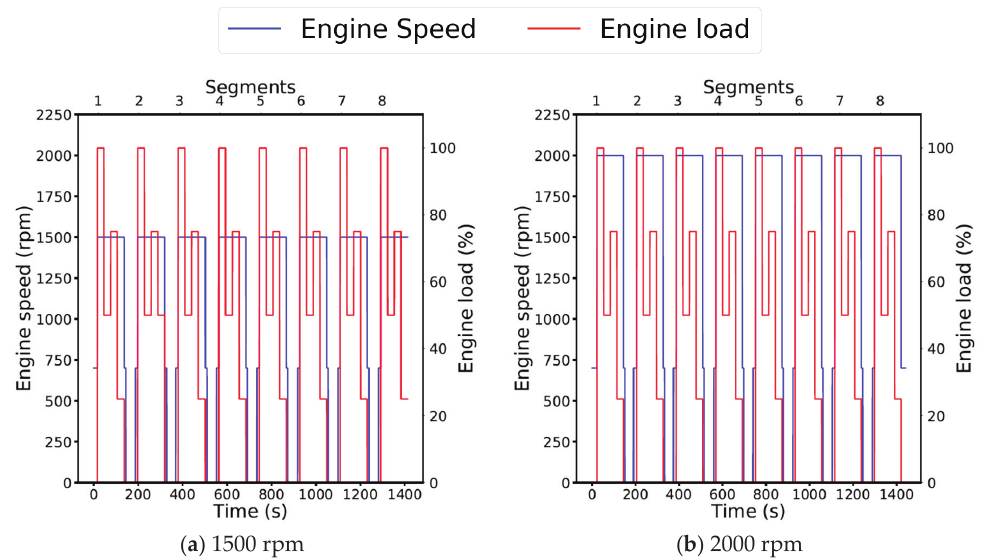
Figure 1. Engine speed and commanded engine load in the custom designed experimental cycle at ( a ) 1500 and ( b ) 2000 rpm. The blue line corresponds to the engine speed and the red line corresponds to the engine load.